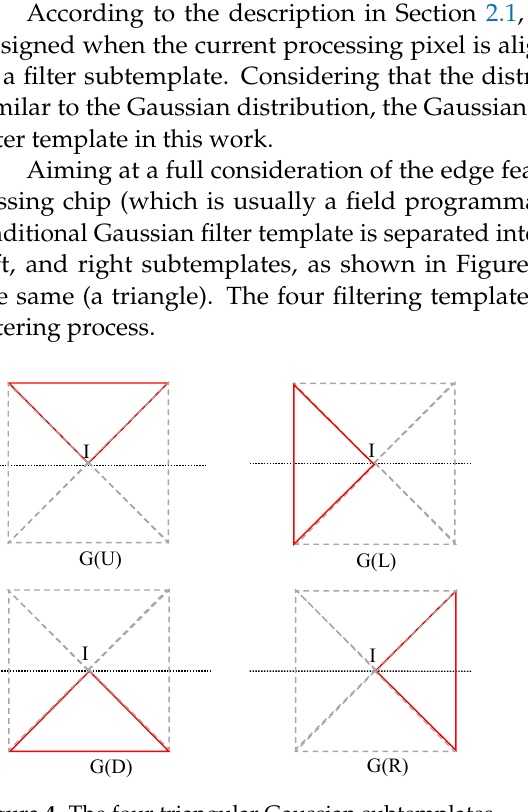
Figure 5. The block diagram of the IGSWF algorithm. Step 1: Gaussian Subtemplate Convolution The pixels are convolved using the Gaussian subtemplates in the four directions: up, down, left, and right. Based on Equation (2), the four following expressions can be ob ‐ tained as follows: